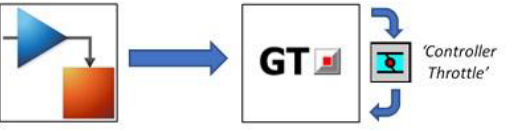
Figure 5. “Controller Throttle” directly implemented in GT-Suite for the operating condition reproduction.